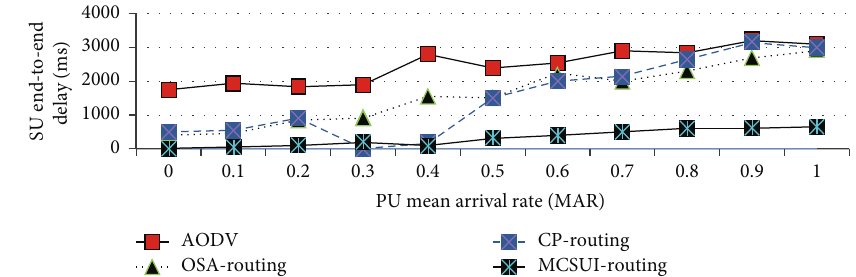
Figure 19: EED of SU for PU’s sd of MAR as 0.4 (user/ms).